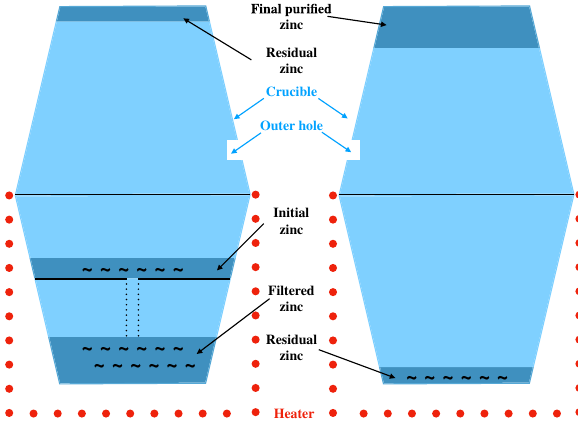
Fig. 1 Scheme of the set-up for zinc purification: a stage of filtration and refining against of the volatile impurities (left); b stage of purifi- cation against of the non-volatile impurities (right). We melt the initial zinc using a heater, obtaining the filtered zinc. We remove most of the volatileimpuritiesthroughtheoutlethole,whileasmallamountofthem remains in the thin layer of condensed zinc, also removed. By further heating the sample, all zinc evaporates, forming a layer of purified zinc, while non-volatile impurities form a residue in the